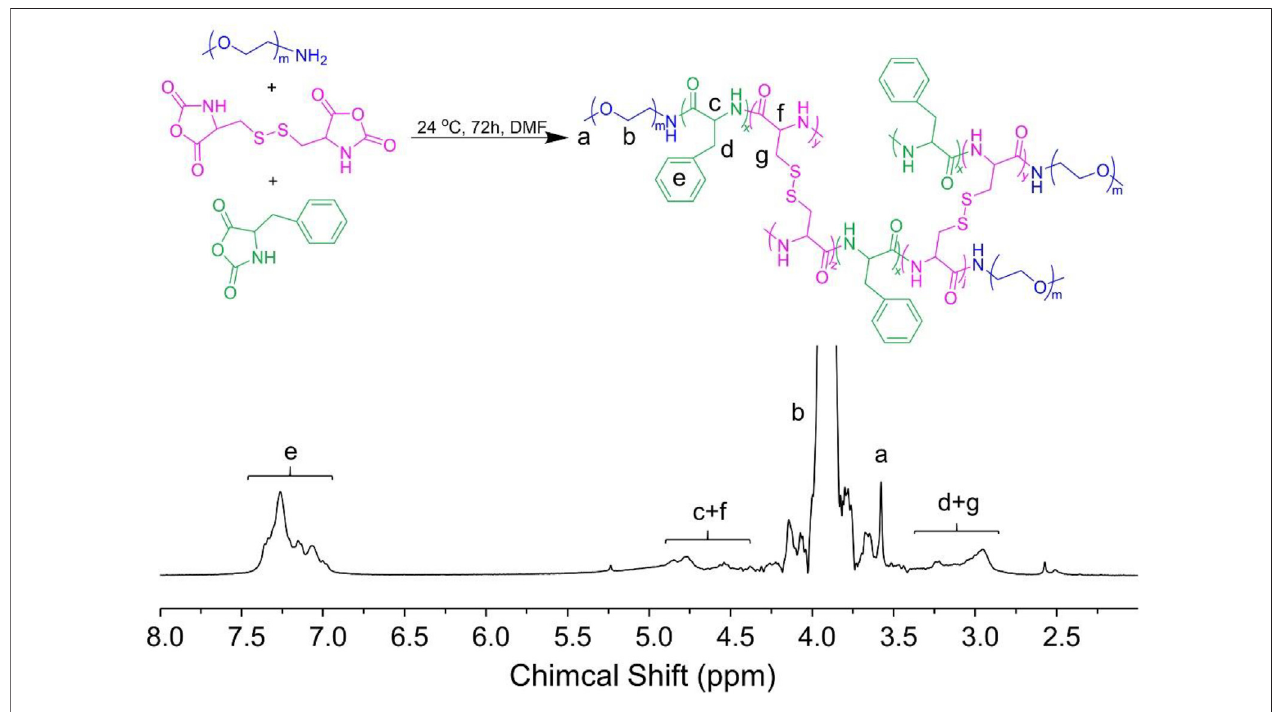
FIGURE 1 | 1 H NMR result of mPEG − P(LP- co -LC).